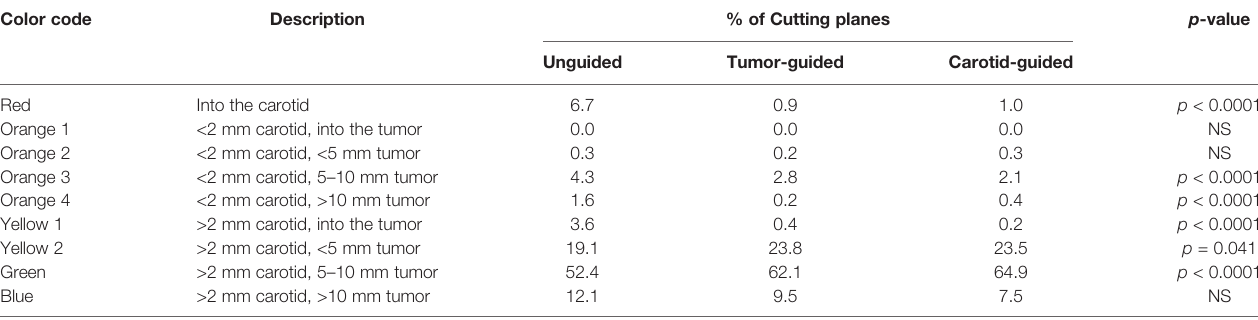
TABLE 2 | Average percentage of points of the virtual margin delineation in each category of the “ color code ” according to the guidance setting. Color